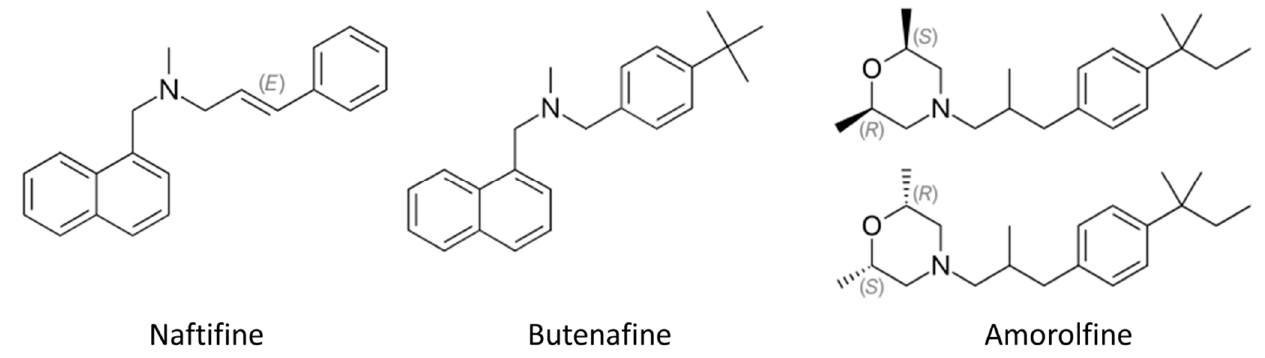
Figure 3. Chemical structure of antifungal amines used for topical applications. (E)—trans isomer, (S)—sinister enantiomer, (R)—rectus enantiomer.